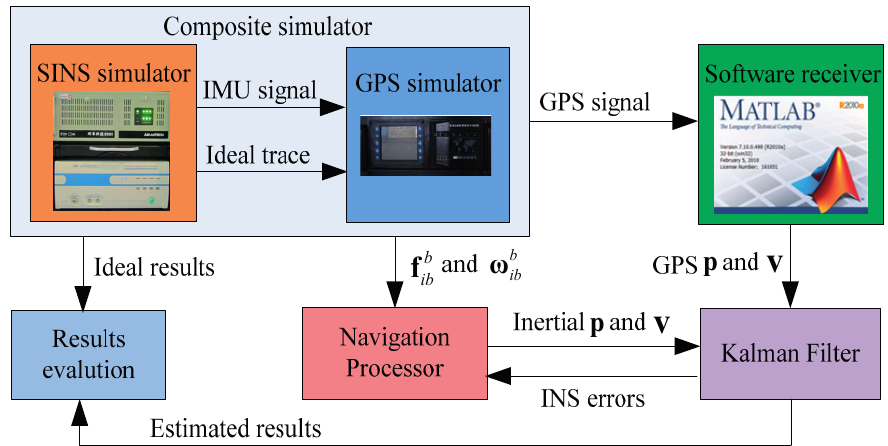
Figure 1. The test system composition based on composite simulator.